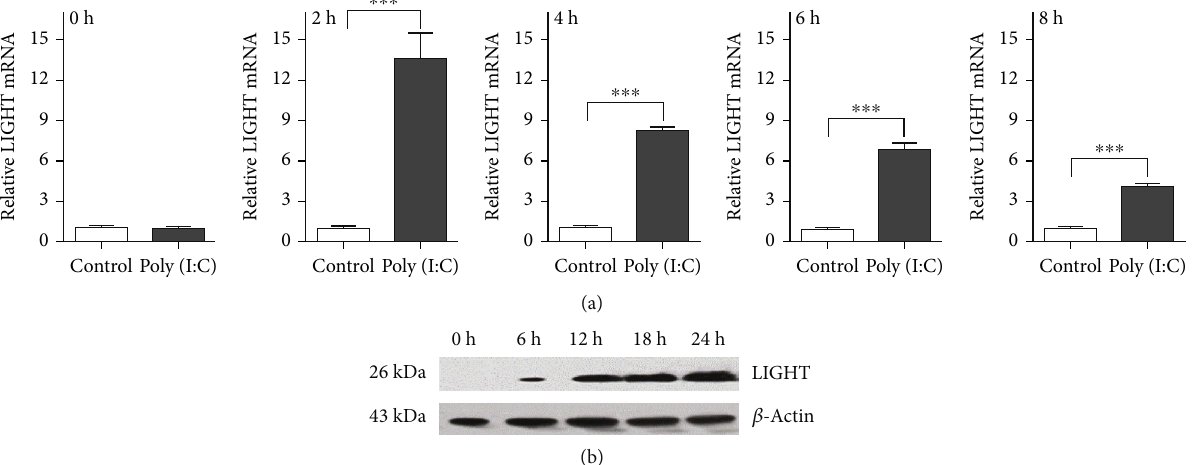
Figure 2: Expression of LIGHT induced by poly(I:C). (a) At the indicated time point, the mice were sacri fi ced and total RNA was extracted from the liver. Expression of LIGHT mRNA was measured by real-time PCR, and data are shown as mean ± SEM ; ∗∗∗ p < 0 : 001 . (b) Expression LIGHT protein was analyzed by western blot at 0 h, 6 h, 12 h, 18 h, and 24 h after poly(I:C)